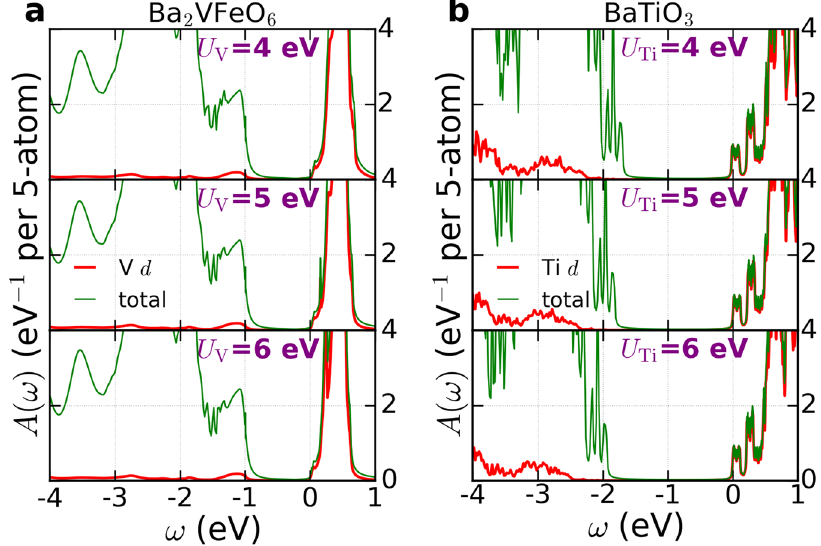
Figure 6. Spectral functions A ( ω ) of tetragonal Ba 2 VFeO 6 and BaTiO 3 as a function of Hubbard U on V and Ti. The unit of A ( ω ) is eV − 1 per 5-atom. Panels a are the results for tetragonal Ba 2 VFeO 6 . Panels b are the results for tetragonal BaTiO 3 . For Ba 2 VFeO 6 , the calculations are performed in a paramagnetic state. For BaTiO 3 , the calculations are performed in a non-magnetic state. In panels a, the green lines are the total spectral functions and the red lines are the spectral functions projected onto V d states. In panels b, the green lines are the total spectral functions and the red lines are the spectral functions projected onto Ti d states. The Fermi level is set at ω = 0